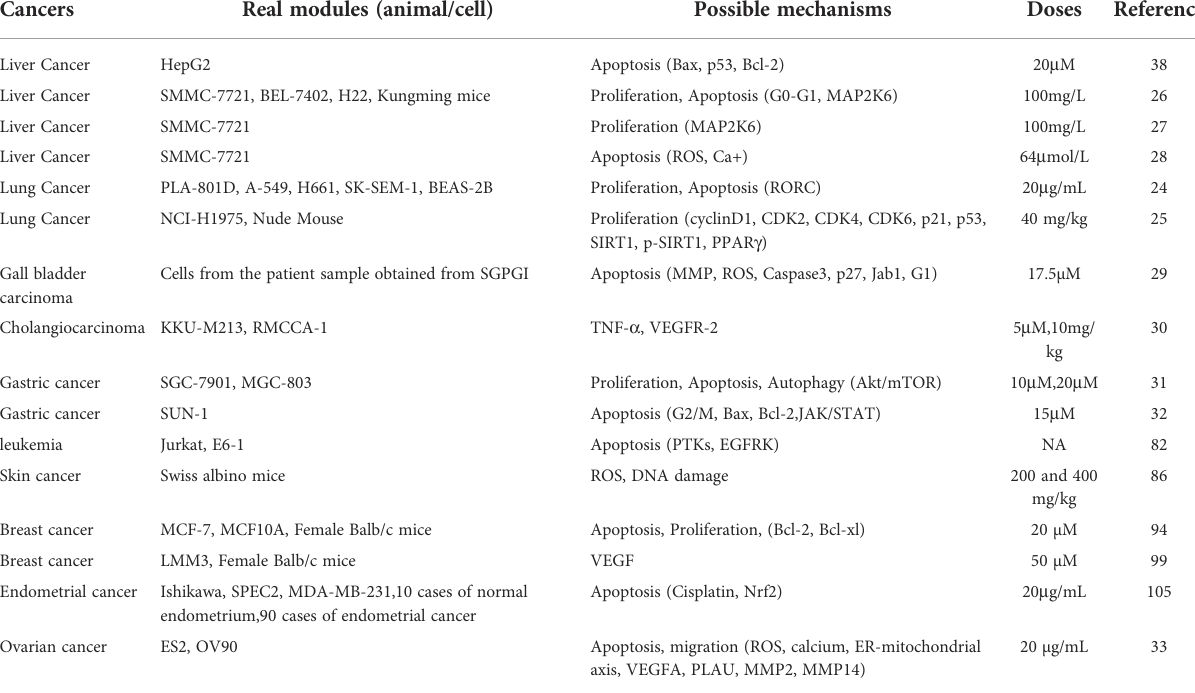
TABLE 1 Real modules, possible mechanisms, doses and reference of Stigmasterol in various cancers. Cancers Real modules (animal/cell)